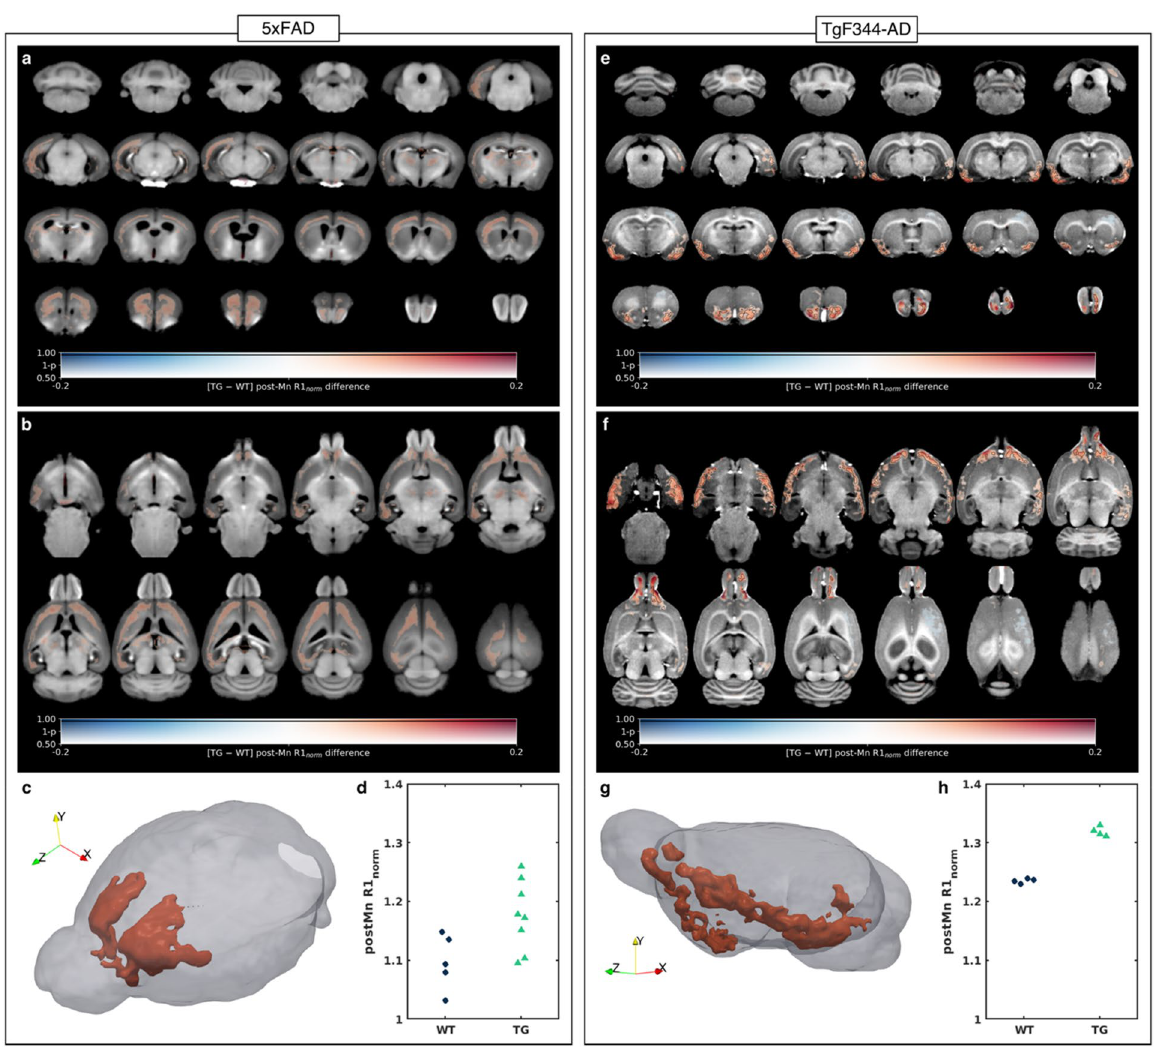
Figure 6. Transgenic animals show regional increases in manganese uptake. ( a , b ) The voxel-wise difference in post-Mn R1 norm (R1 values were normalized to the median R1 in a manually defined region in the temporalis muscle) between 5xFAD (TG, n = 8) mice and wild-type (WT, n = 5) littermates, overlaid on the T1-weighted MP2RAGE study-specific template shown in ( a ) coronal slices from back to front and ( b ) transverse slices from bottom to top. The difference in group means is coded by overlay color (warm colors indicate TG > WT), and the statistical significance is coded by overlay transparency (completely transparent indicates family-wise- error-corrected p > 0.5). ( c ) 3D rendering of the template brain (gray) and a cortical region of interest (ROI) automatically generated from the largest connected component in which p < 0.3 (red). ( d ) A dot plot of the mean post-Mn R1 norm within the ROI for each mouse. Two-tailed two-sample t-test, p = 0.028. ( e , f ) Similar maps as in ( a , b ), showing the voxel-wise difference in post-Mn R1 norm between TgF344-AD (TG, n = 4) rats and wild-type (WT, n = 4) littermates, overlaid on the pre-Mn T1-weighted MP2RAGE study-specific template. Areas in which p < 0.05 are outlined in black. ( g ) 3D rendering of the template brain (gray) and an ROI in the rhinencephalon automatically generated from the largest connected component in which p < 0.05 (red). ( h ) A dot plot of the mean post-Mn R1 norm within the rhinencephalon ROI for each rat. Two-tailed two-sample t-test, p <